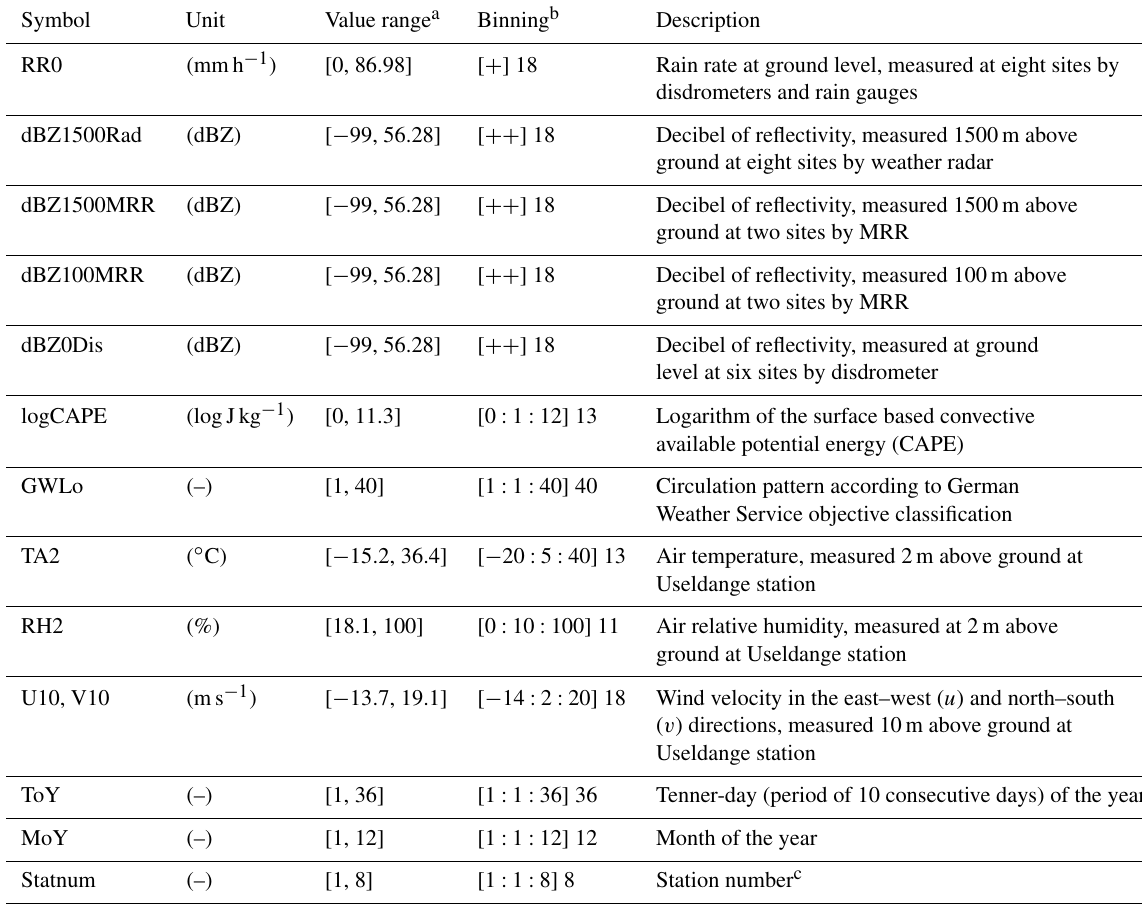
Table 1. Summary of the raw data used in the experiments: description, summary statistics and